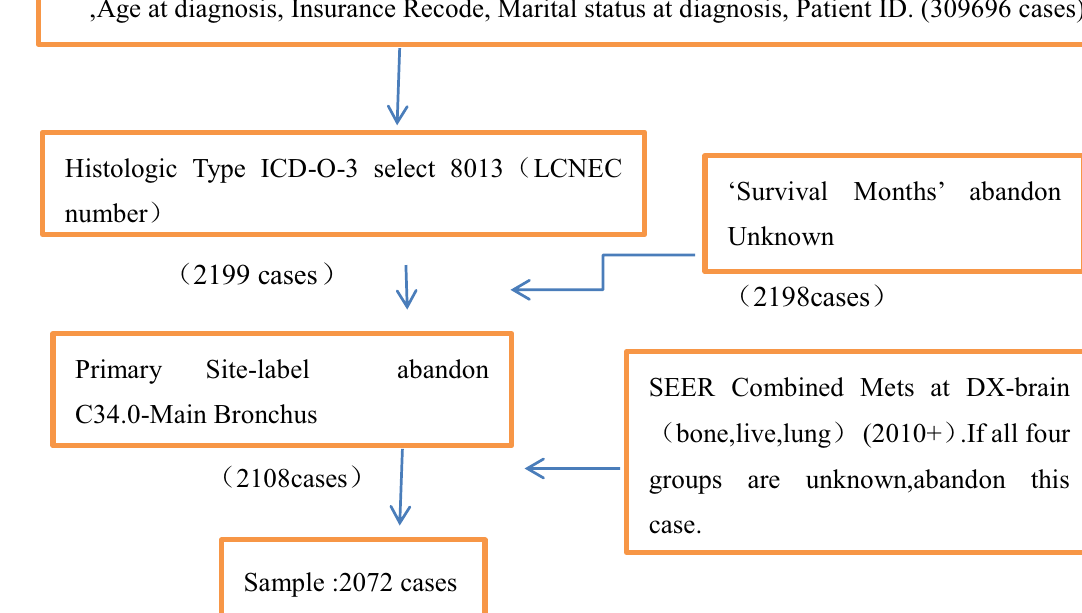
Table select Race,Sex,Site recode ICD-O-3/WHO 2008,Primary Site,Histologic Type